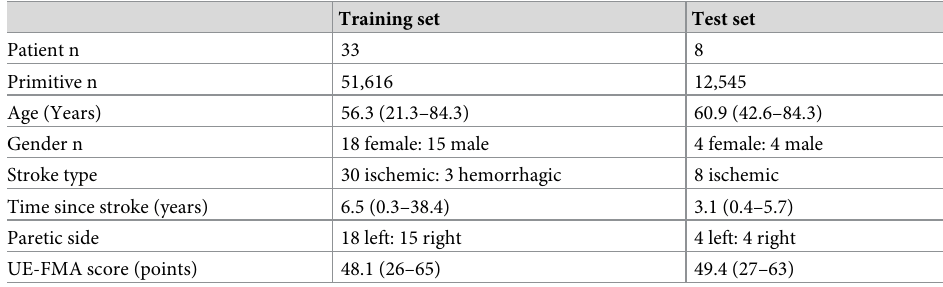
Table 1. Demographics and clinical characteristics of